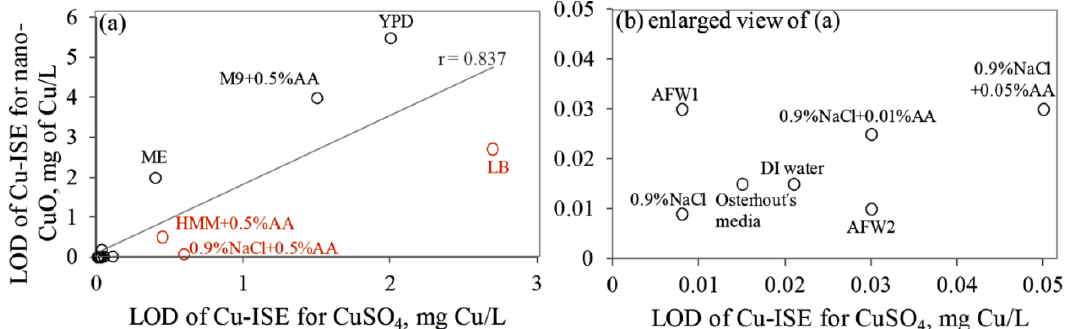
in CuSO and in nano-CuO suspensions LOD 4 4